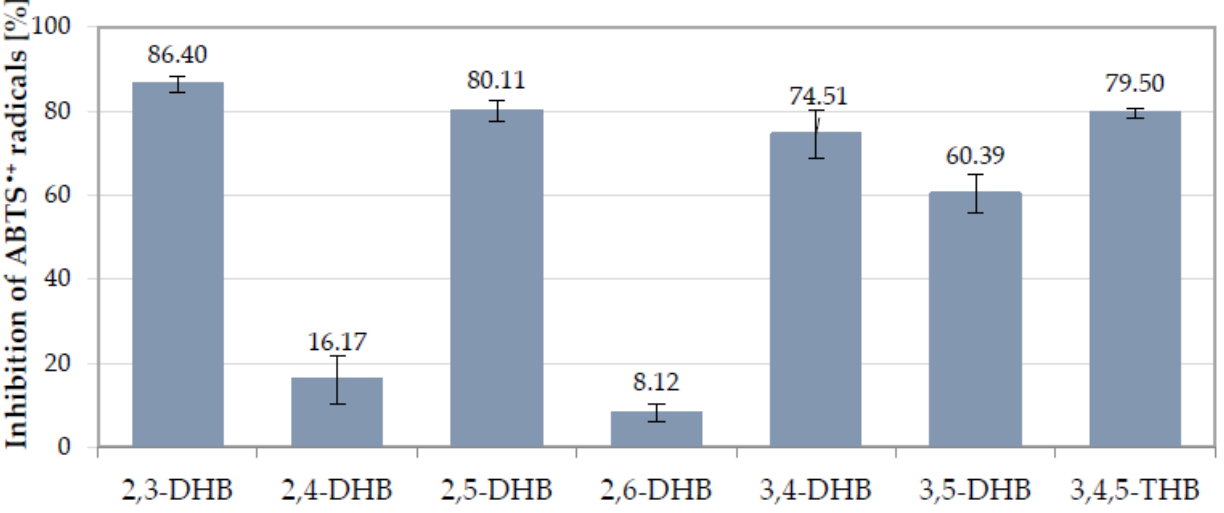
Figure 3. Comparison of the percentage of inhibition of ABTS •+ cation radicals measured after 7 min of reaction time for the tested hydroxybenzoic acids at a concentration of 50 μM (methanolic solutions). Mean values from three independent experiments ± SD are shown.